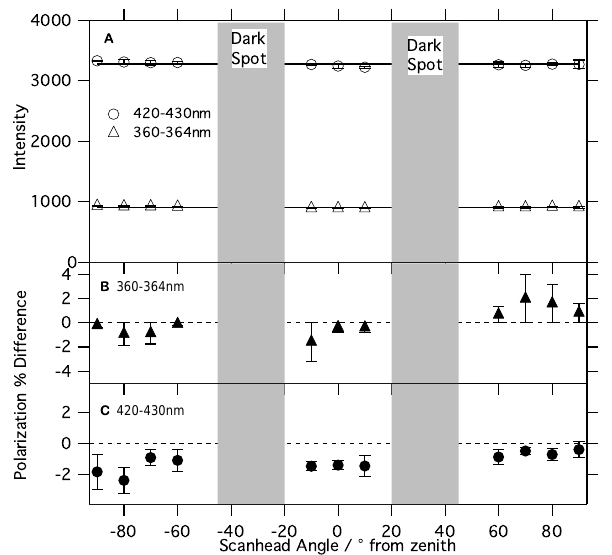
Fig. 5. Instrumental characterization. Panel A demonstrates con- stant light intensity observed at different scan head view angles over two different wavelength regions (420–430nm and 360–364nm). These data points are the average of six different spectra and show standard deviations (1 σ ) of less than one percent. Panels B and C show the average percent difference, 100% *(V-H)/(H+V)/2, with +/-1 σ error bars in intensity between horizontally and vertically polarization-filtered light. The small percent differences indicate that the system is minimally biased by polarized light.